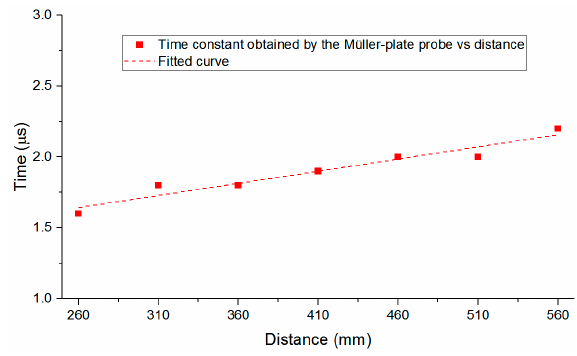
Figure 10. Decay constants obtained by the Müller-plate probe vs. distance.